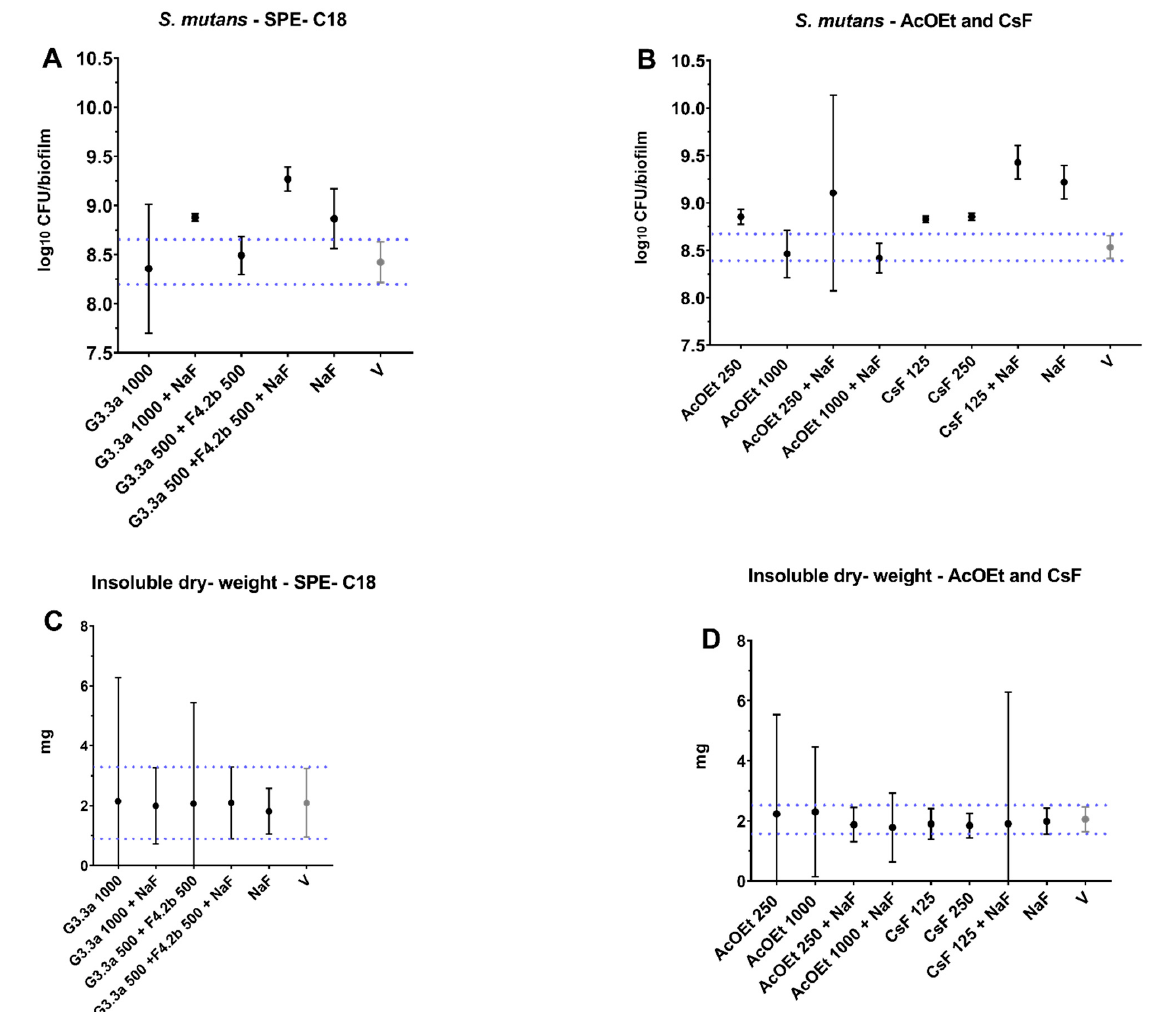
Figure 5. Characterization of biofilms after topical treatments. ( A ) Bacterial population (log 10 CFU/biofilm) of the SPE-C18 fractions; ( B ) bacterial population (log 10 CFU/biofilm) of BRA/DF_AcOEt and Caseargrewiin F (CsF) fractions; ( C ) dry weight (mg) for biofilms treated with SPE-C18 fractions; ( D ) dry weight (mg) for biofilms treated with BRA/DF_AcOEt and Caseargrewiin F. The central data are the mean, and the error bars are the confidence interval (95% CI). The dotted lines use vehicle data to compare the effectiveness of tested treatments. The vehicle control is represented as V (with the concentration being 10.52% EtOH for the SPE-C18 fractions, 21.04% EtOH and 3.75% DMSO for the AcOEt_BRA/DF fractions, and 10.52% EtOH and 1.87% DMSO for CsF). The experiments for SPE-C18, AcOEt_BRA/DF, and CsF 125 µg/mL were performed in duplicate on one experimental occasion ( n = 1) and in duplicate on two separate occasions ( n = 2) for CsF 250 µ